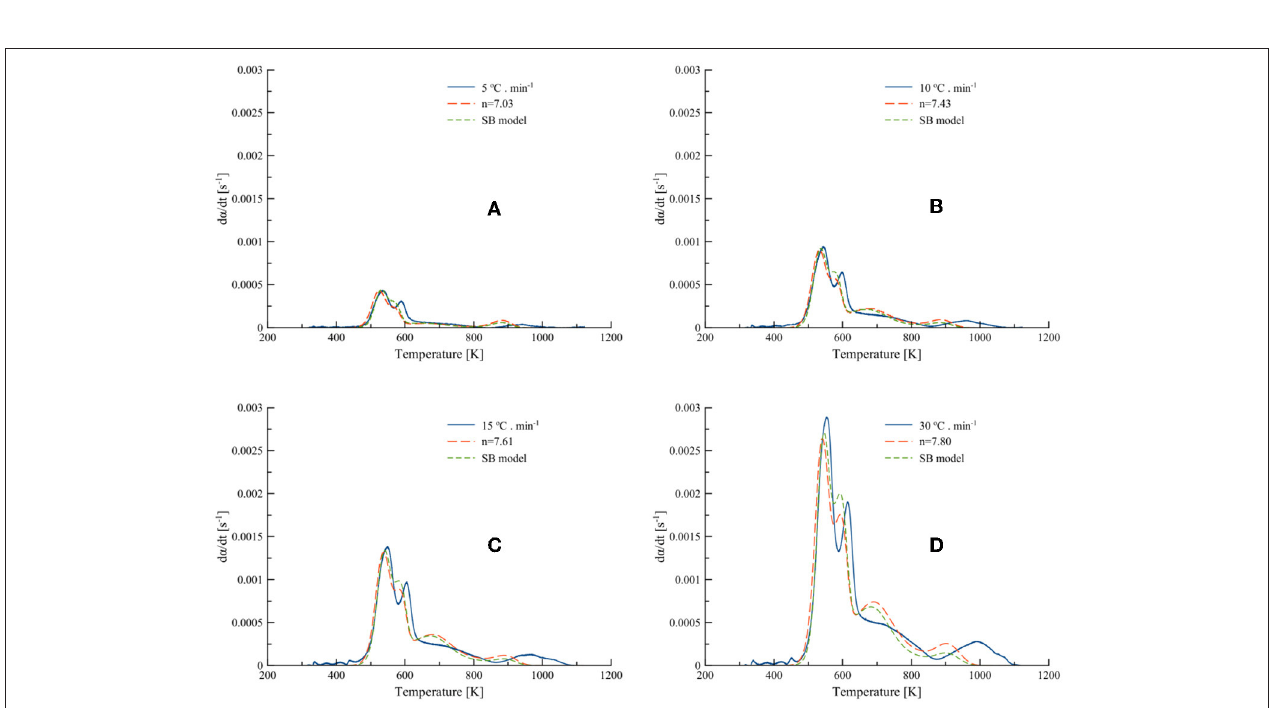
FIGURE 5 | Best-fit DTG curves of Turbinaria ornata with optimized order-based and SB model parameters at (A) 5, (B) 10, (C) 15, and (D) 30 ◦ C